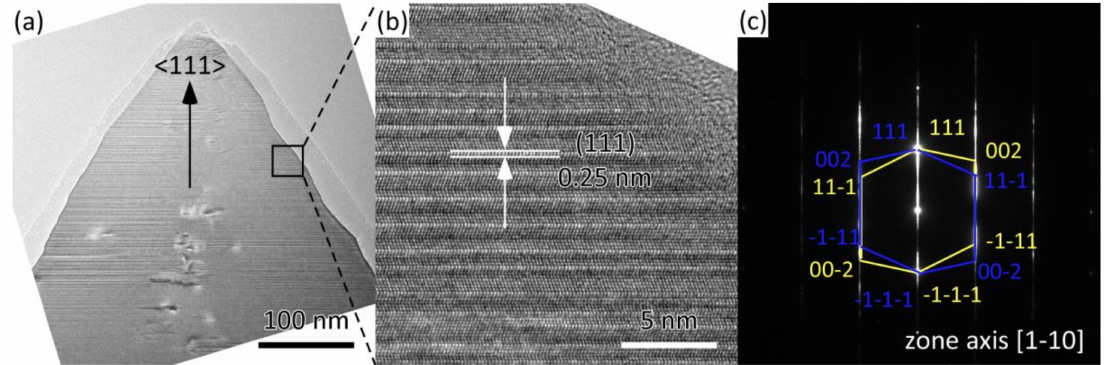
Figure 5. Transmission electron microscopy (TEM) images of sample B1 prepared at P tot = 4 kPa, and T dep = 1673 K. ( a ) the cross-sectional TEM BF images; ( b ) the magnified area of the BF image of the tip; ( c ) the SAED image for sample B1.